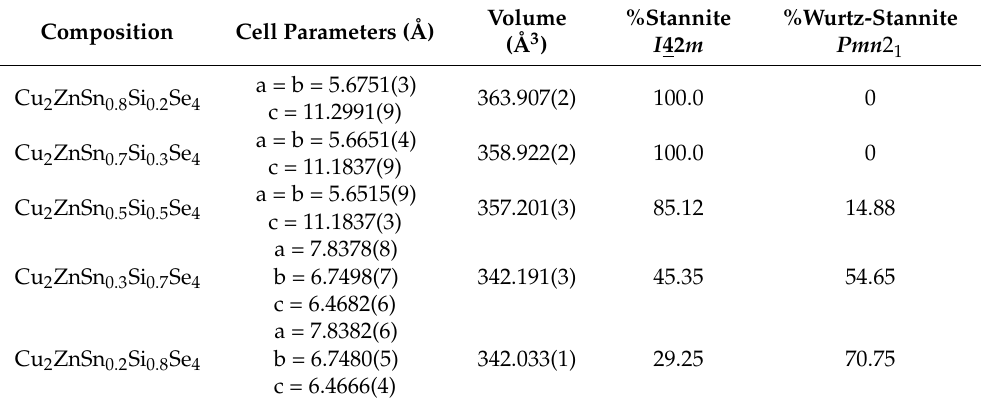
Table 1. Rietveld refinement of cell parameters for Cu 2 ZnSn 1 − x Si x Se 4